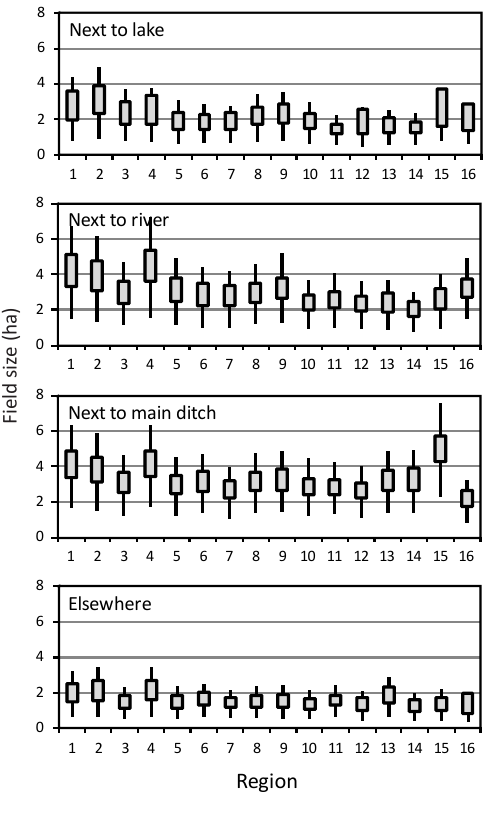
Fig. 4. Regional differences in field size (ha) next to lake, river, main ditch and elsewhere (≥300 m from waterways). The upper part of the line indicates upper quartile, the lower part of line lower quartile, the top of the box mean field size (ha) and the bottom of the box median for field size. Regions, see Figure